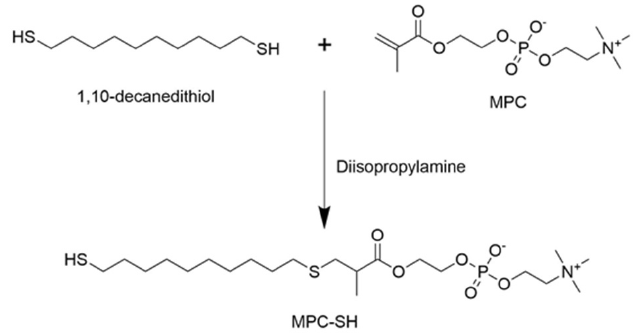
Figure 1. MPC-SH synthesis from 1,10-decanedithiol and MPC.